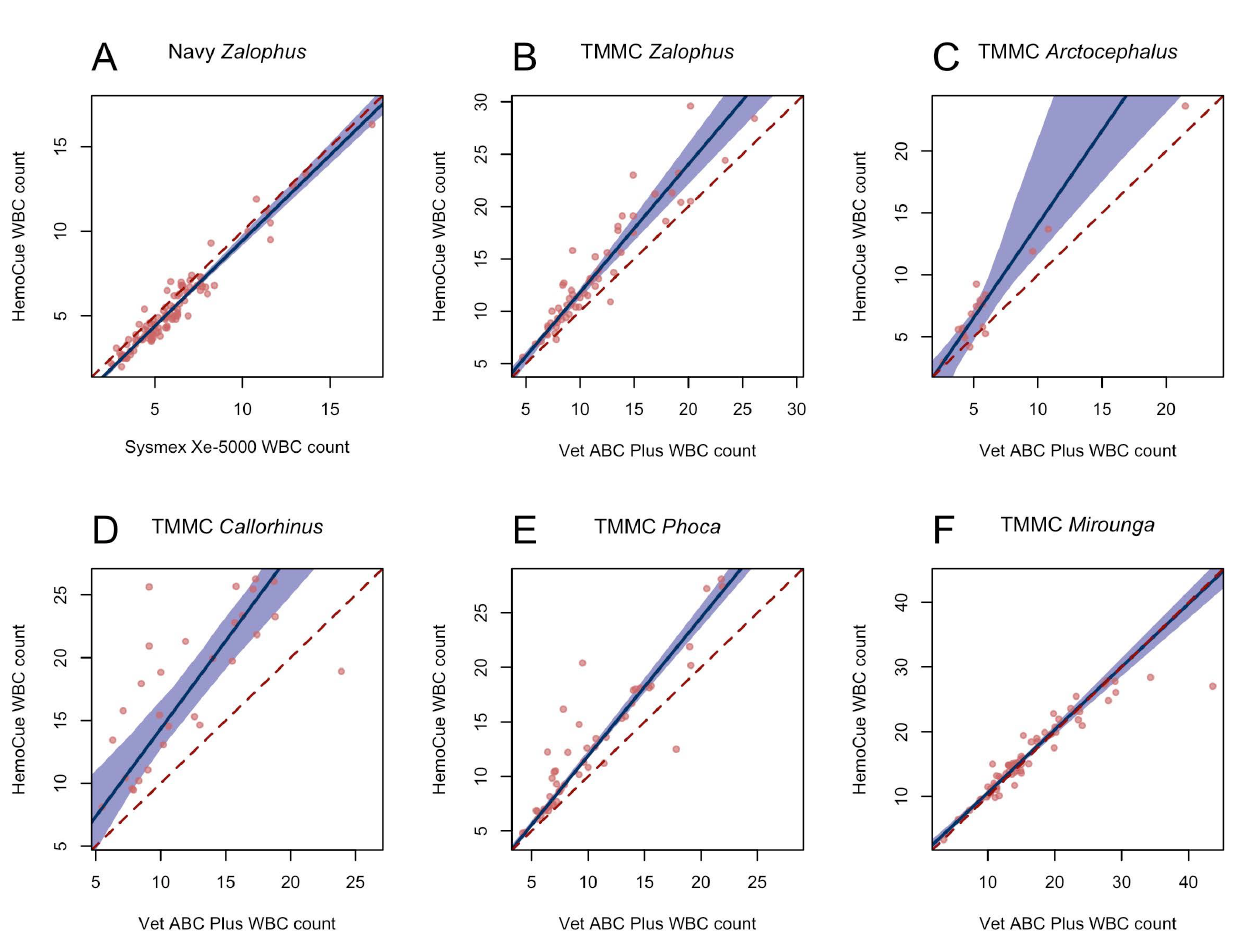
Figure 2. Passing-Bablok plots comparing the corrected WBC counts between the comparative analyzers and the HemoCue ® WBC system for each species. Units for both comparative instruments and the HemoCue ® WBC System are (10 9 /L). ( A ) Passing-Bablok regression of the U.S. Navy Marine Mammal Program California sea lion ( Zalophus californianus ) samples comparing the Sysmex Xe-5000 to the HemoCue ® WBC system. The WBC count from the Sysmex Xe-5000 is depicted on the x-axis. ( B ) Passing-Bablok regression of The Marine Mammal Center (TMMC) Zalophus samples comparing the Vet ABC Plus automated hematology analyzer to the HemoCue ® WBC system. The WBC counts from the Vet ABC Plus are depicted on the x-axis. The WBC counts from the HemoCue ® WBC system are depicted on the y-axis. ( C ) Passing-Bablok regression of TMMC Guadalupe fur seal ( Arctocephalus townsendi ) samples comparing the Vet ABC Plus automated hematology analyzer to the HemoCue ® WBC system. The WBC counts from the Vet ABC Plus are depicted on the x-axis. The WBC counts from the HemoCue ® WBC system are depicted on the y-axis. ( D ) Passing-Bablok regression of TMMC Northern fur seal ( Callorhinus ursinus ) samples comparing the Vet ABC Plus automated hematology analyzer to the HemoCue ® WBC system. The WBC counts from the Vet ABC Plus are depicted on the x-axis. The WBC counts from the HemoCue ® WBC system are depicted on the y-axis. ( E ) Passing-Bablok regression of TMMC harbor seal ( Phoca vitulina ) samples comparing the Vet ABC Plus automated hematology analyzer to the HemoCue ® WBC system. The WBC counts from the Vet ABC Plus are depicted on the x-axis. The WBC counts from the HemoCue ® WBC system are depicted on the y-axis. ( F ) Passing-Bablok regression of